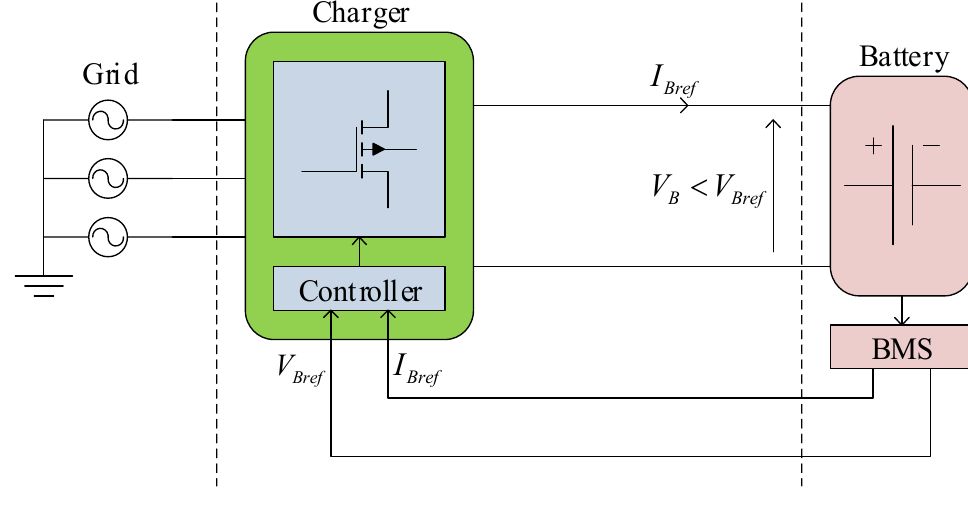
Figure 3. Ultra-fast charging system.